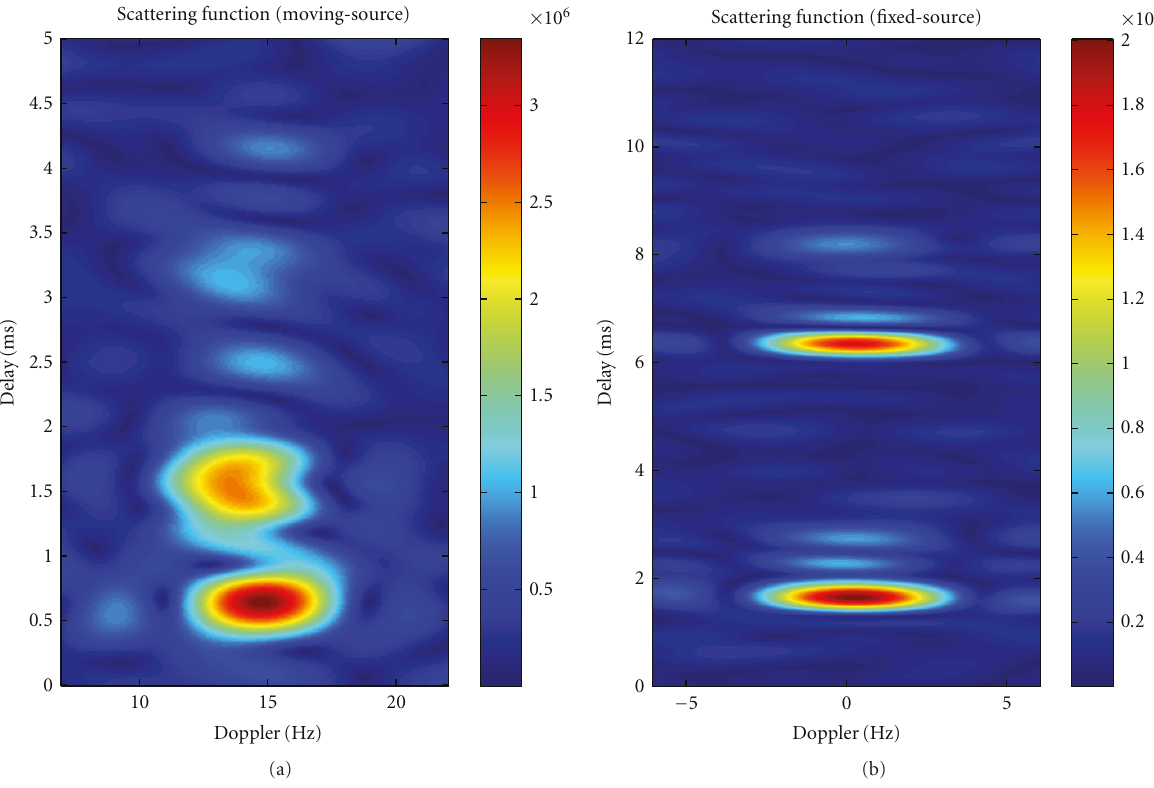
Figure 12: Channel scattering